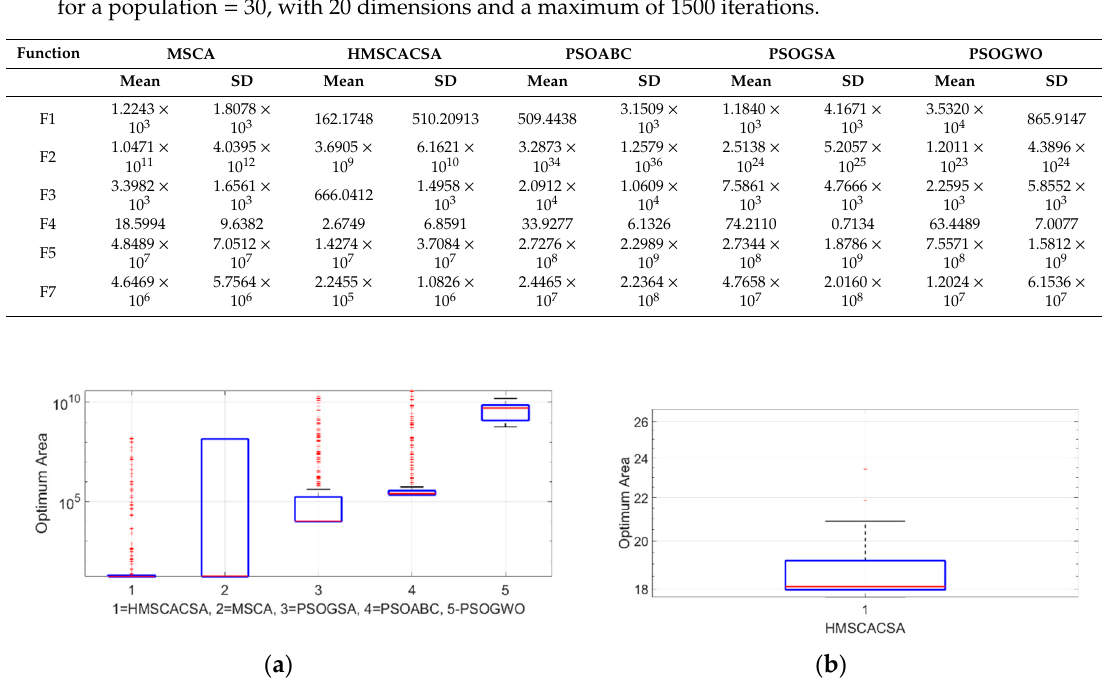
Figure 7. Convergence boxplot for ( a ) solving function F5 with 1500 independent runs (between hybrid-to-hybrid metaheuristic) and ( b ) the HMSCACSA for function F5.